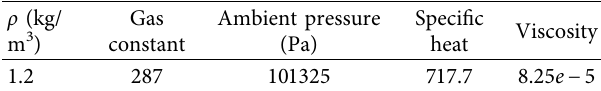
Table 4: Air model and state equation